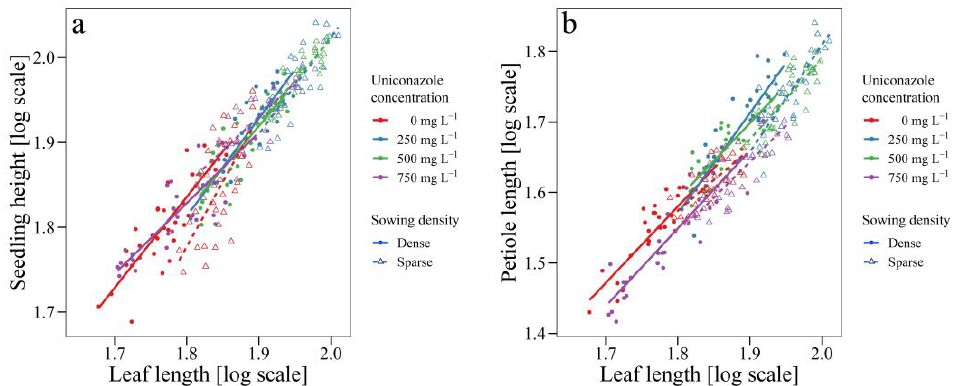
Figure 4. Treatment effect on the allometric relationship between seedling traits. Standardized major axis (SMA) relationship between seedling height and leaf length ( a ) and between petiole length and leaf length ( b ) within two sowing densities and various uniconazole concentrations. (See Table 3 for further information regarding SMA regression results). Table 3. Standardized major axis (SMA) regression results for the effect of treatments on the allome- tric relationships between plant traits.